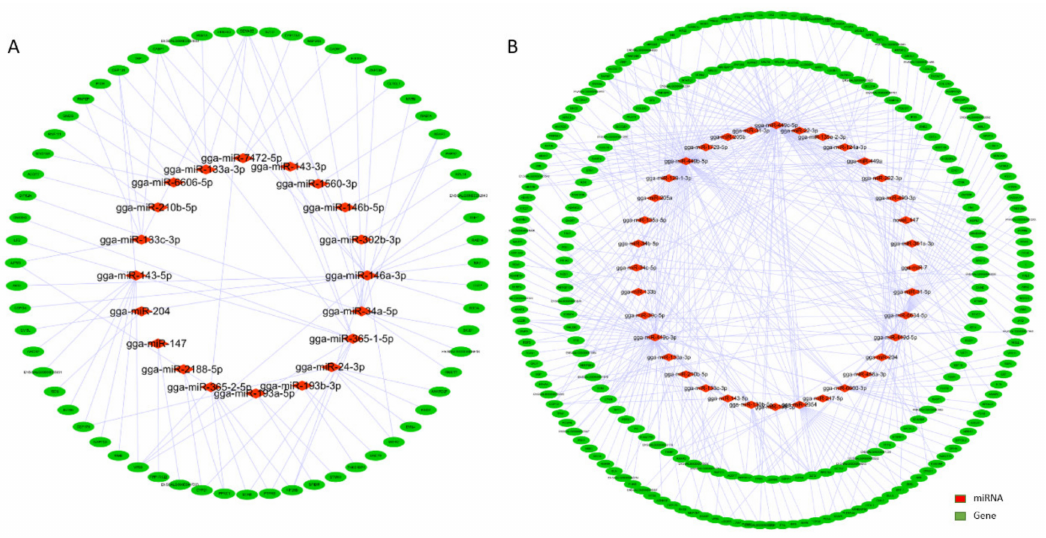
Figure 2. The interaction network of DE miRNA-di ff erentially expressed gene (DEG). ( A ) The interaction network of the upregulated miRNA and downregulated target genes. ( B ) The interaction network of downregulated miRNAs and upregulated target genes. The red rhombus and green oval represent the miRNAs and predicted target genes,